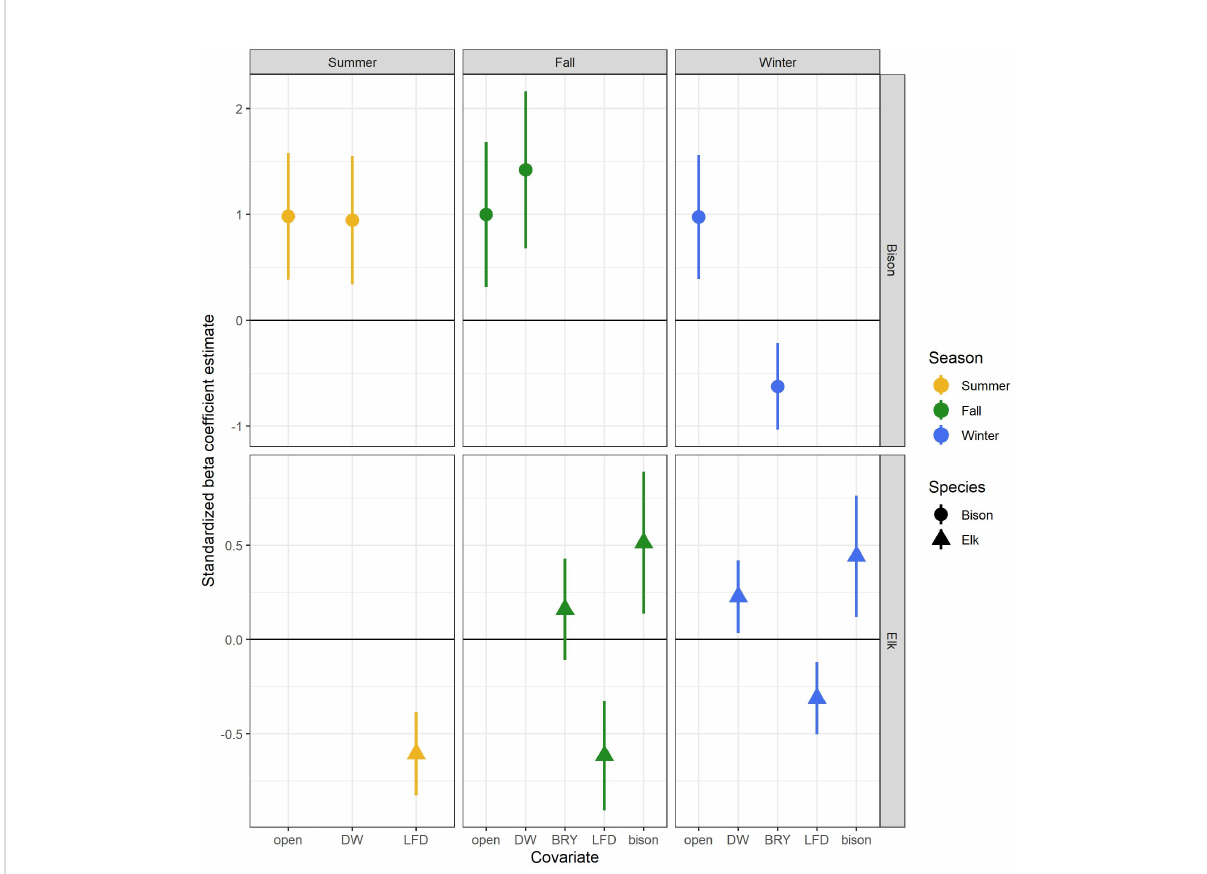
FIGURE 2 Scaled beta coef fi cient estimates from the top-ranked models for bison and elk space use during three seasons: summer (April-August), fall (September-November), and winter (December-March). Camera trap data were collected from 2016-2020 in Elk Island National Park in Alberta, Canada. Error bars represent 95% con fi dence intervals. Covariate descriptions are provided in Table